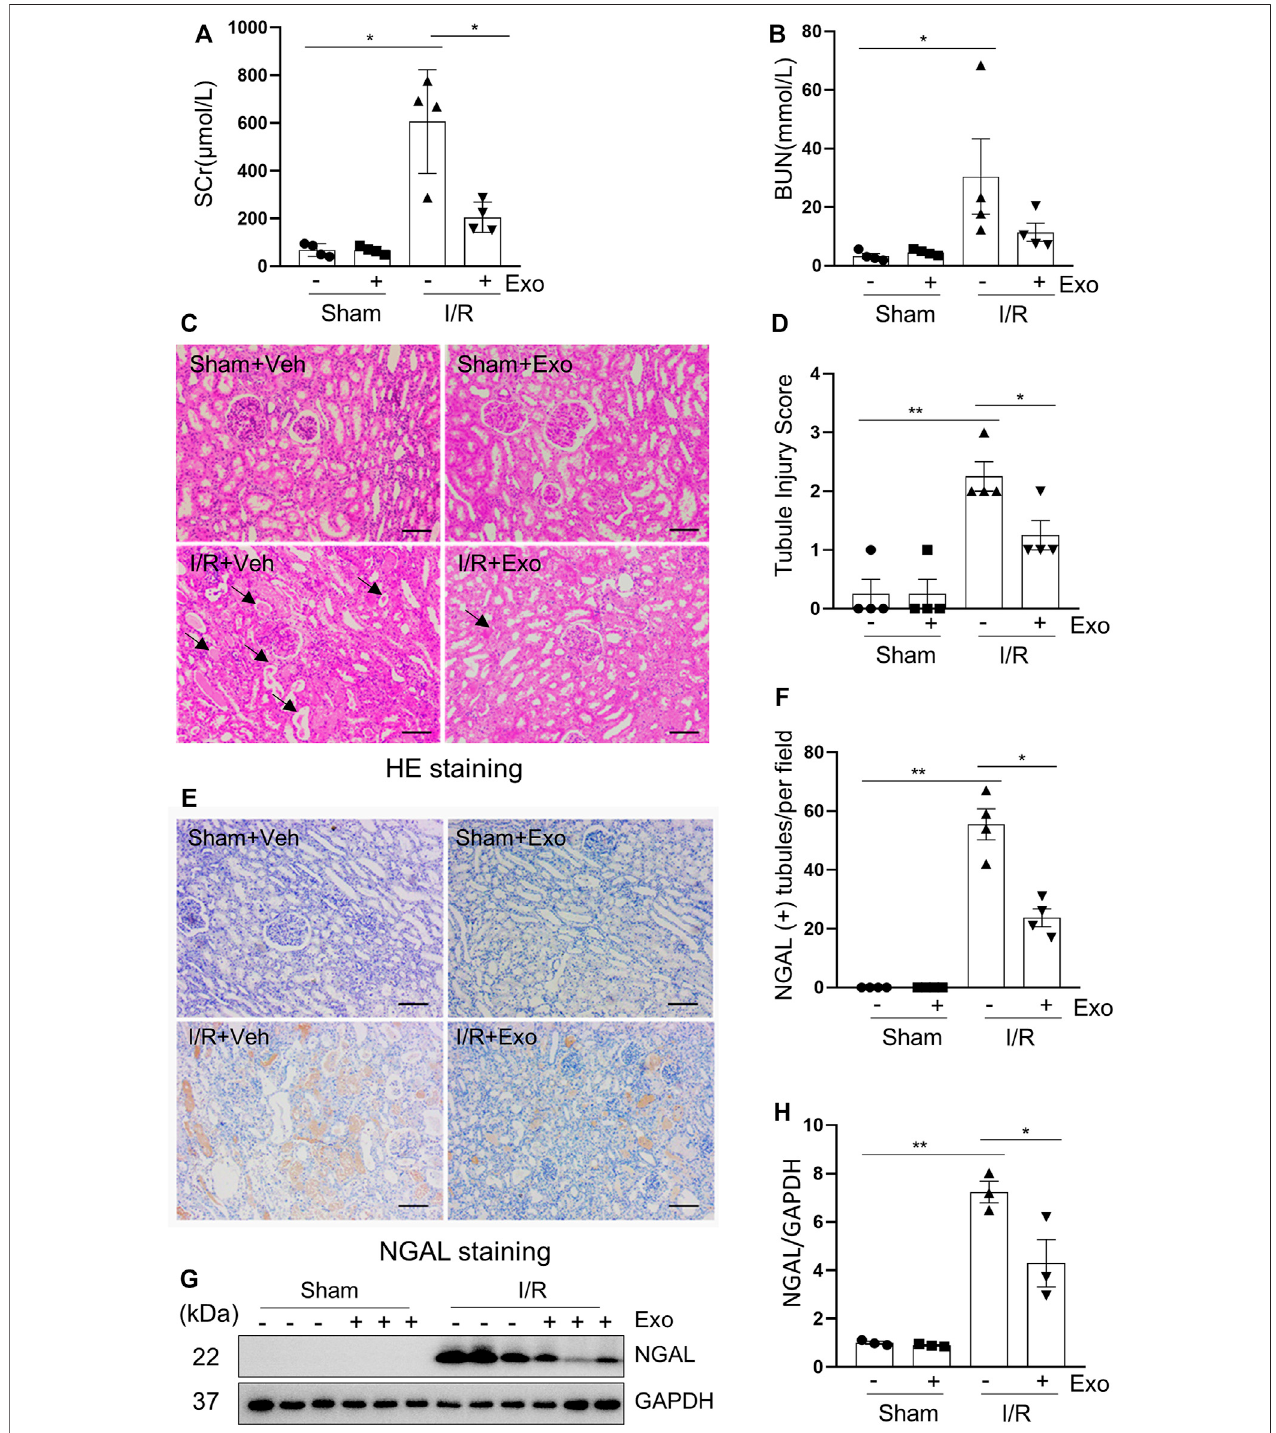
FIGURE4| Therenalischemia-reperfusioninjuryinminiaturepigswassigni fi cantlyreducedafterexosomestreatment. (A,B) Serumcreatinine(SCr)andbloodurea nitrogen(BUN)at72 haftertreatment. (C) Photomicrographsillustratinghematoxylinandeosinstainingofkidneytissuefromfourgroups.Arrowspointtoinjuredtubules with intraluminal casts. Scale bar = 100 µm. (D) Tubule Injury was scored and graphed to analyze the severity of renal tubular injury. (E) Photomicrographs illustrating immunohistochemical staining of NGAL. Scale bar = 100 µm. (F) Quanti fi cation and plot of the percentage of NGAL positive tubules from immunohistochemical staining. (G) Porcine kidney tissue lysates from four groups were subject to immunoblot analysis with speci fi c antibodies against NGAL. (H) Expression levels of NGAL were quanti fi ed by densitometry analysis and then normalized with GAPDH. Data are means ± sem.* p < 0.05; ** p < 0.01 versus sham controls.